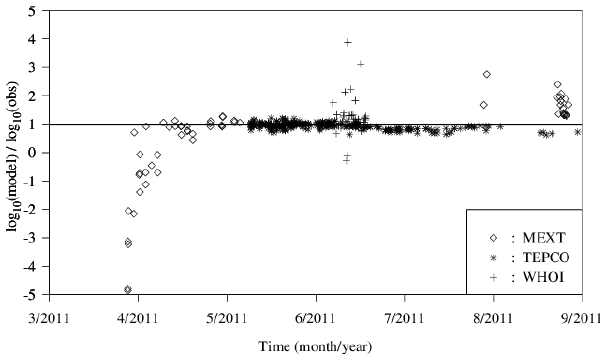
Fig. 8. Logarithmic ratio of the high-resolution nested model- computed surface 137 Cs concentration to the observation at MEXT, TEPCO and WHOI measurement sites over the period 26 March– 31 August